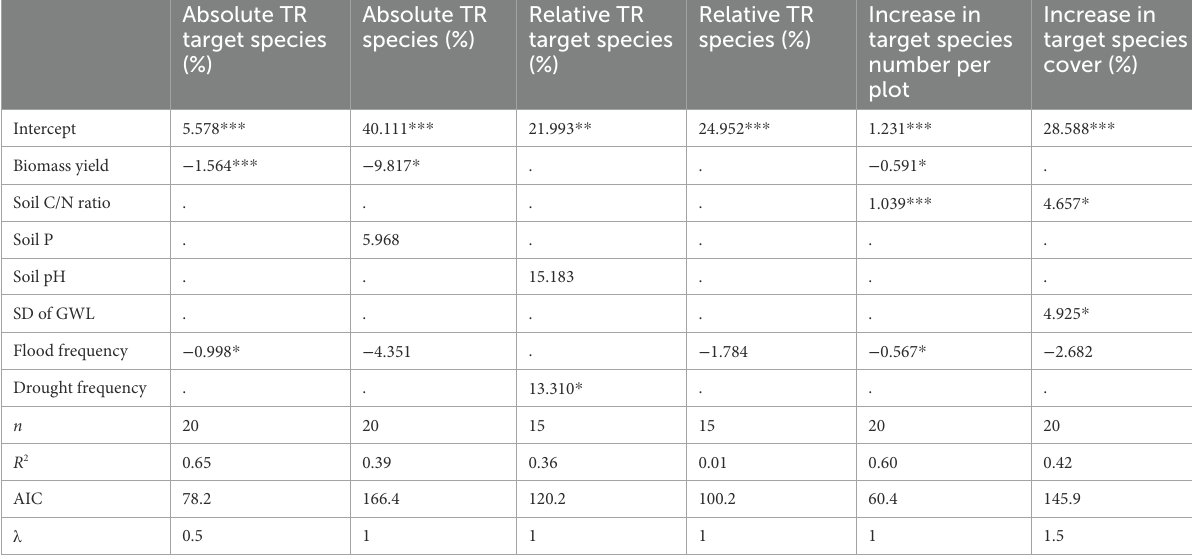
TABLE 2 Overview of the regression models selected by AIC criterion for the ecological restoration success variables on the site